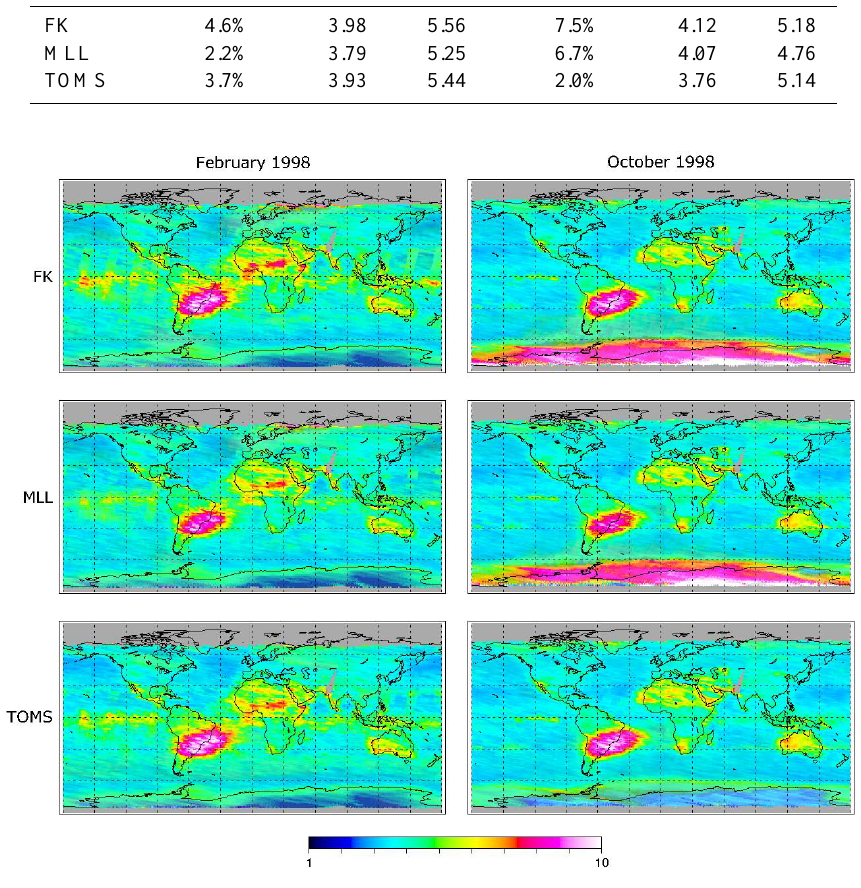
Fig. 8. Mean number of iterations for February 1998 (left panels) and October 1998 (right panels). In the rows the used ozone climatologies: FK, MLL and TOMS at a fixed relative error of